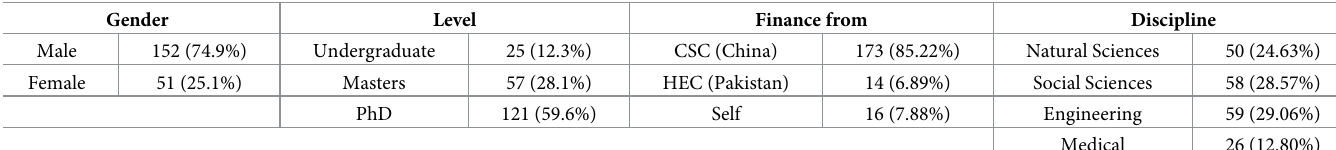
Table 1. Demographic information of the participants background of